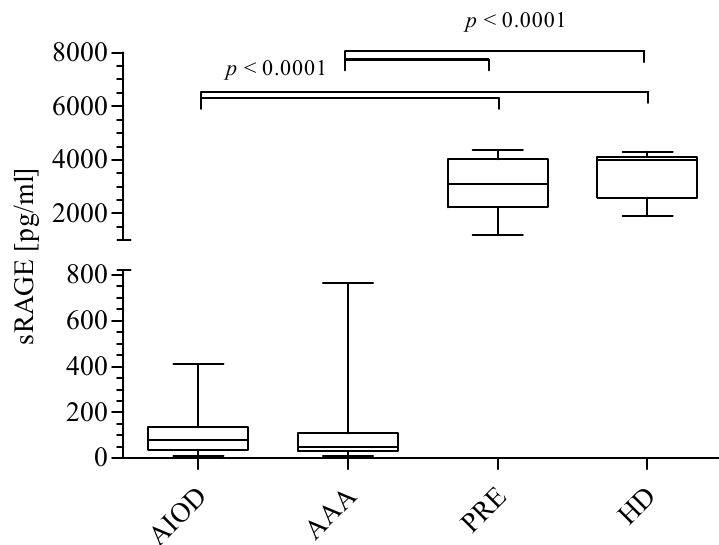
Figure 2. sRAGE level in the studied groups expressed as pg/mL. Data were analyzed using the Kruskal–Wallis test, followed by Dunn's multiple comparison test.